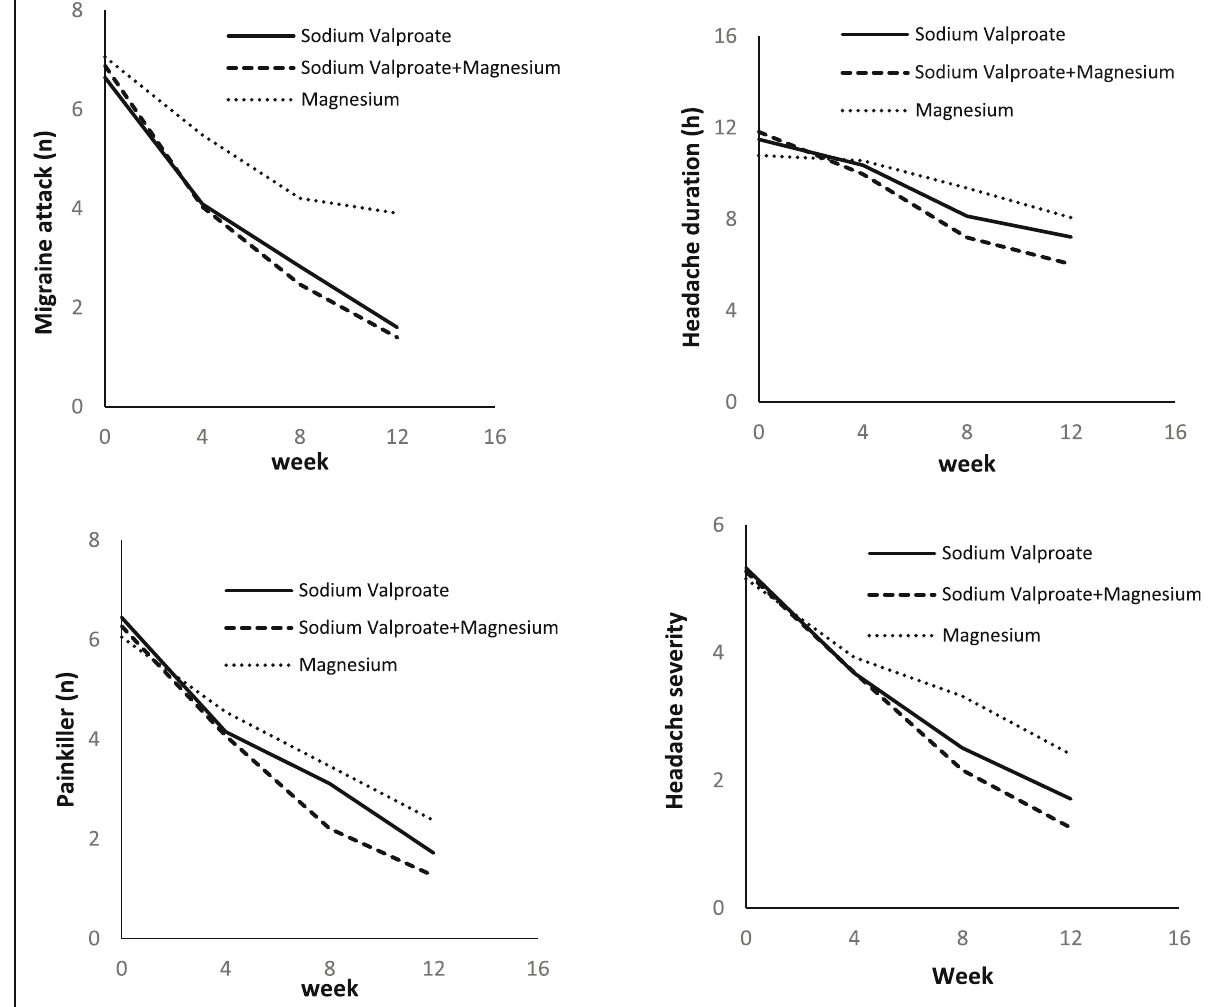
Fig. 3 Intra group comparison of duration, severity, number of attack and painkiller in different treatment